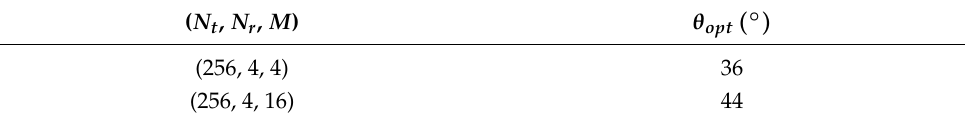
Table 2. Optimal rotation angle, θ opt , for CQSM system